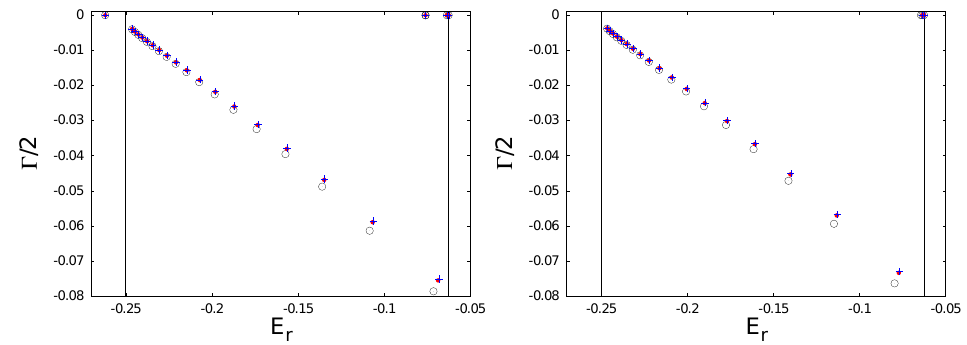
Figure 6. 1 S and 3 S resonances of the e − Ps system between the n = 1 and n = 2 thresholds. Black circles indicate data using cut-off parameters x 0 = 4, y 0 = 12, red dots indicate data using cut-off parameters x 0 = 8, y 0 = 24, and blue + symbols indicate data using cut-off parameters x 0 = 8, y 0 = 12. Thresholds indicated with vertical